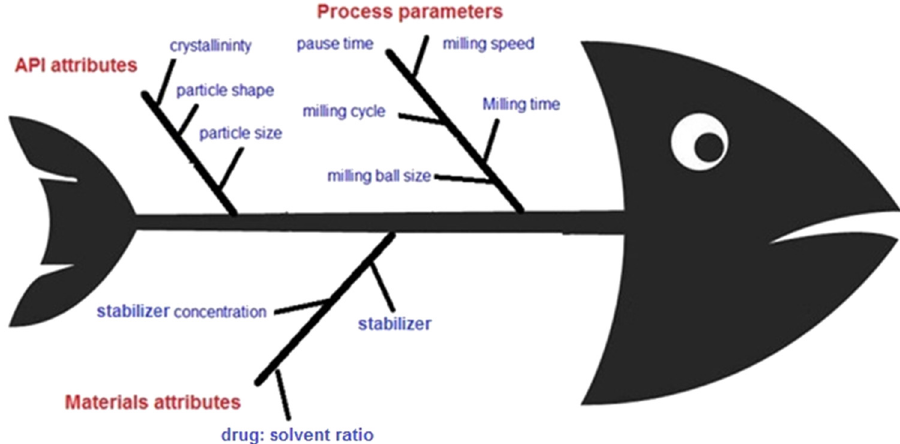
Figure 5: Ishikawa Fishbone diagram for the e ff ect of CMAs and CPPs on the CQAs of APG nanoparticle formulation prepared by planetary ball wet